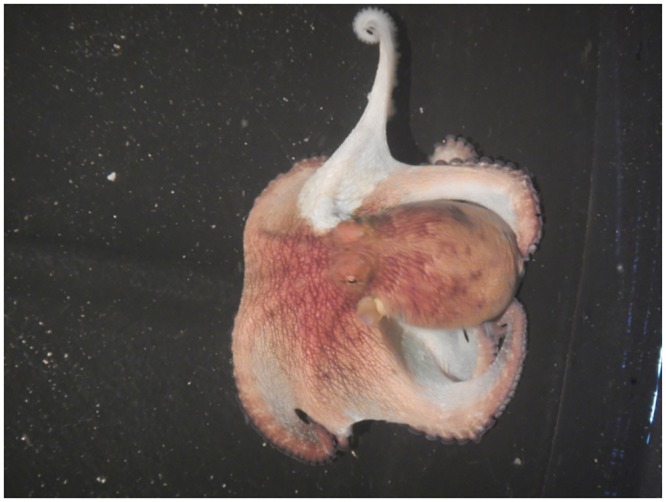
Effect of the relaxing fraction (F3) injected in the arm of an Octopus maya conspecific.The injected arm is paling, an effect caused by serotonin in the saliva.